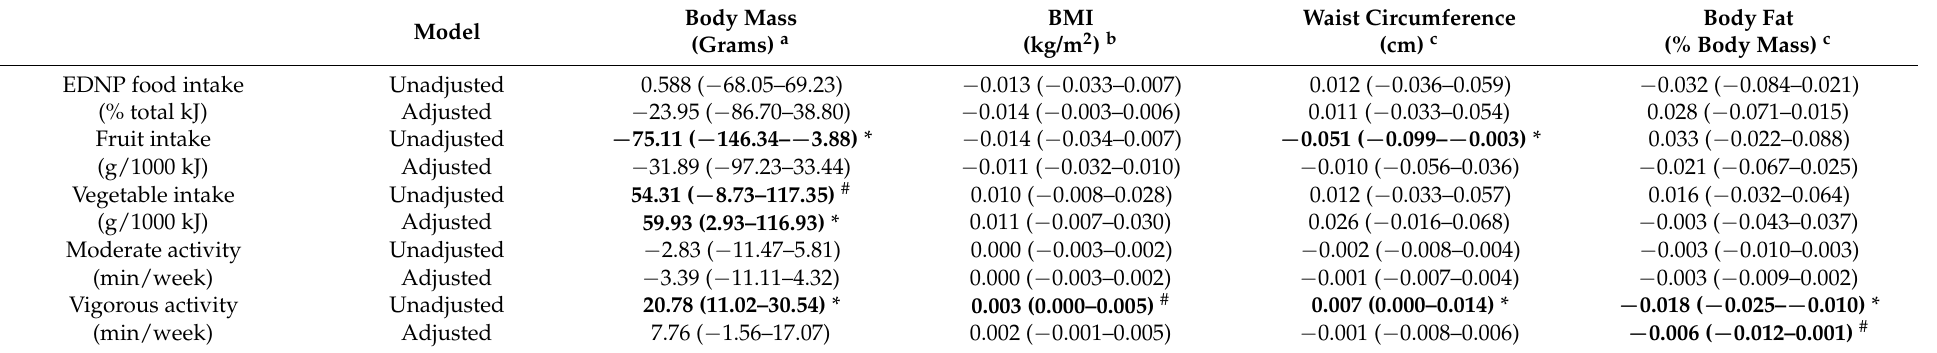
Table 4. Multiple regression of body composition with diet and physical activity variables. ß-Coefficient (95% CI) reported.